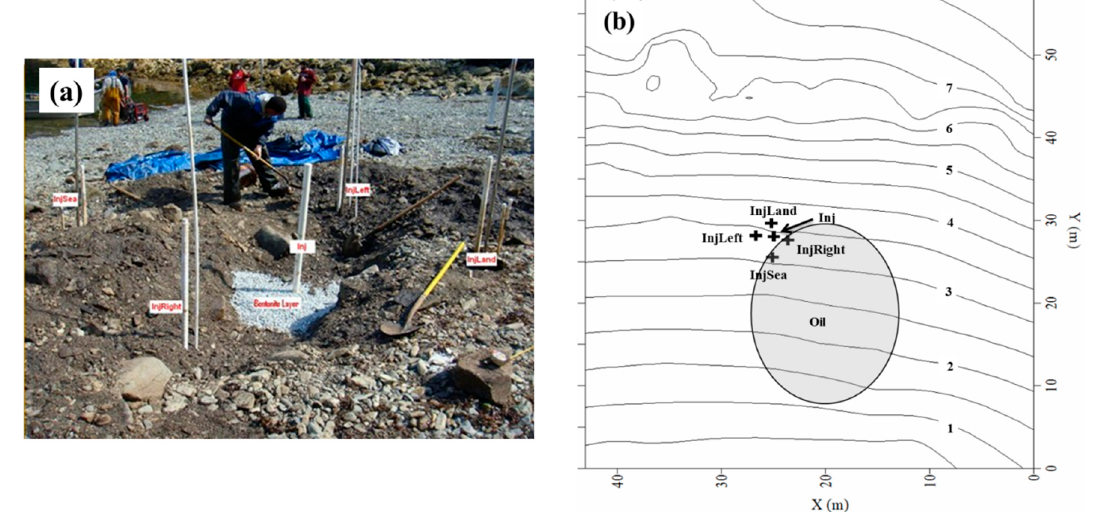
Figure 1. ( a ) The injection well along with four surrounding sampling wells in the field. Note that the sea is to the left in this figure. ( b ) Top view showing the topographic contours of Beach EL056C. The injection well (labeled Inj) is at the approximate location x = 25 m, y = 28 m. It is surrounded by four observation wells: On the landward side (InjLand), on the seaward side (InjSea), on the left (InjLeft), and on the right (InjRight).